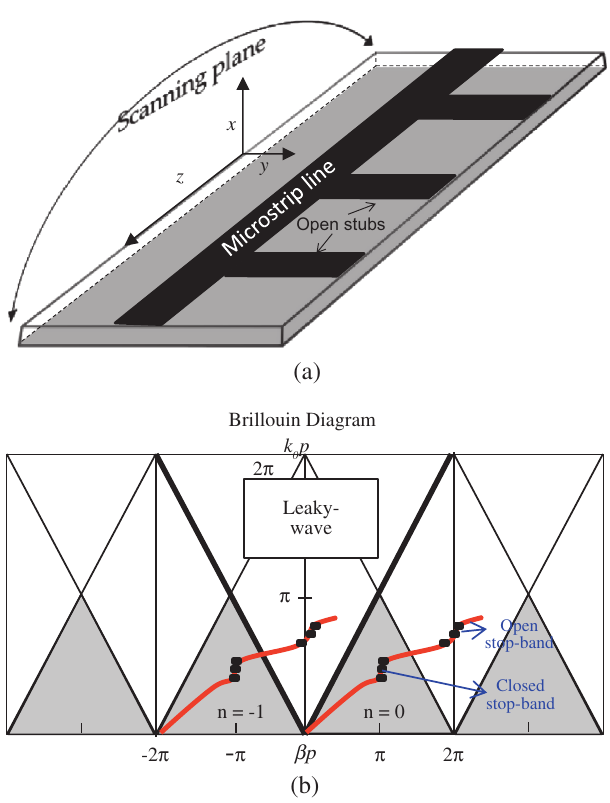
Figure 1. (a) Typical periodic LWA using a periodic arrangement of stubs along a microstrip line. (b) A representative brillouin ( b p (cid:2) k 0 p ) diagram of a periodic leaky-wave antenna. Grey shaded region is the slow-wave region, where the modes are strongly bound to the surface and the region within the cone bounded by straight b p = ± k 0 p lines, indicated by thick black solid lines, is the leaky- wave region, where radiation